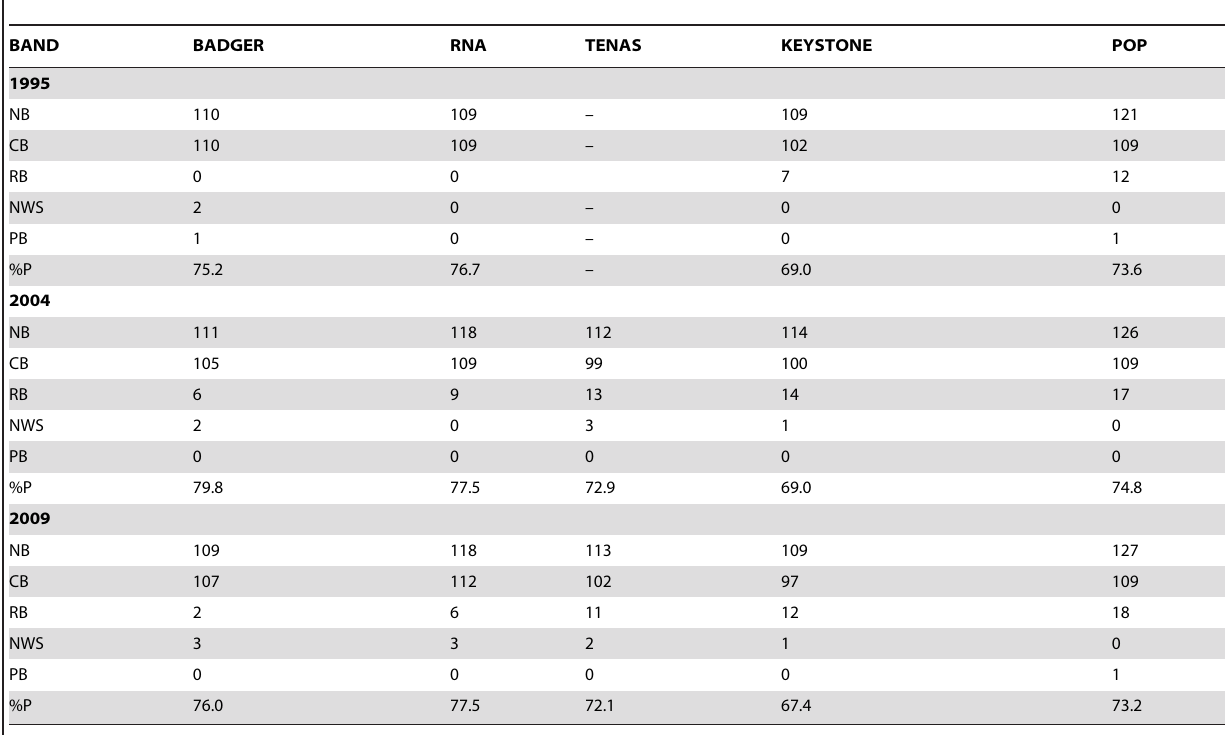
Table 2. AFLP band patterns and % polymorphic loci for four populations and for the combined populations (POP), sampled for three time